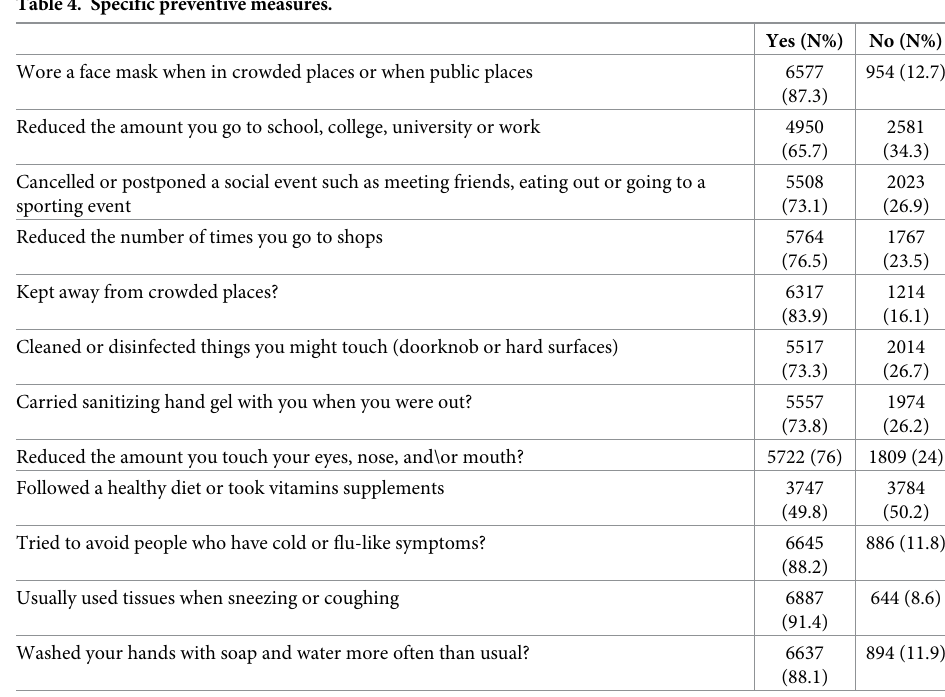
Table 4. Specific preventive measures. Wore a face mask when in crowded places or when public places Reduced the amount you go to school, college, university or